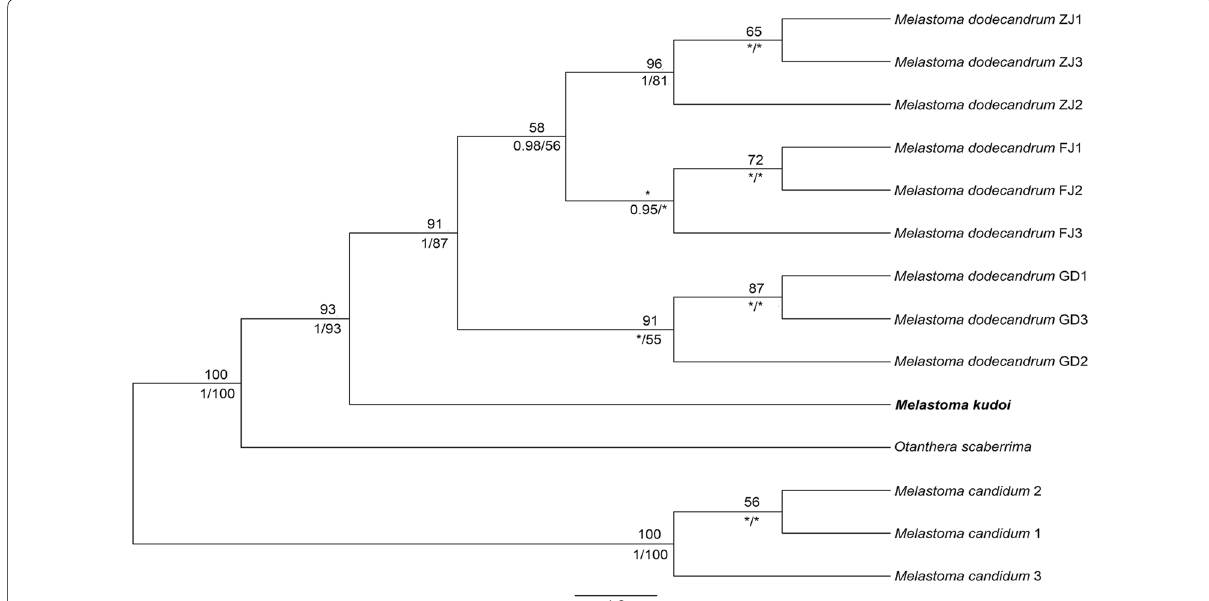
Fig. 4 Maximum likelihood (ML) phylogenetic tree based on the concatenated 6 nuclear genes. Numbers above branches are bootstrap values obtained from ML analysis, and those below branches are Bayesian posterior probabilities (left) and bootstrap values (right) resulting from MP analysis. FJ, GD and ZJ denote the three sampling localities of M. dodecandrum. For species with no intraspecific sequence variation, the sequences of one individual was used in the analyses. Asterisks indicate low support values (PP < 0.90, BS <